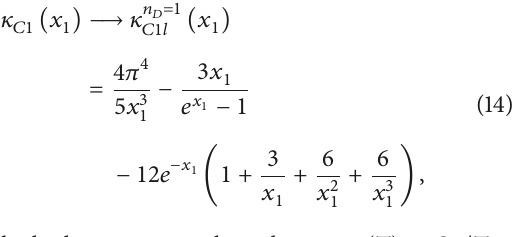
Figure 1: Graphical representation of the exact 𝑥 1 -dependencies (—) of the normalized low-phonon-energy contributions to lattice heat capacities of Debye and non-Debye type, 𝜅 𝐶1 (𝑥 1 ) and 𝜅 𝐶2 (𝑥 1 ) (see (10)), in comparison with the respective low-temperature approximations ( ⋅ – ⋅ – ⋅ – ⋅ ), due to the functions 𝜅 𝑛 𝐷 =1 𝐶1𝑙 (𝑥 1 ≥ 𝑥 𝑐1(𝐷) ) (see (14)) or 𝜅 𝑛 𝑁 =1 𝐶2𝑙 (𝑥 1 ≥ 𝑥 𝑐2(𝐷) ) (see (16)), the associated high-temperature approximations (– ––– –), due to the functions 𝜅 𝑚 𝑅 =7 (𝑥 ≤ 𝑥 ) (see (15)) or 𝜅 𝑚 𝑅 =6 (𝑥 ≤ 𝑥 ) (see (17)), and the 1 𝑐1(𝐷) 1 𝑐2(𝐷) 𝐶1ℎ 𝐶2ℎ normalized heat capacity contribution of the first Einstein oscillator (– ⋅ ⋅ –), 𝜅 𝐸1 (𝑥 1 ) = ((𝑥 1 /2)/ sinh (𝑥 1 /2)) 2